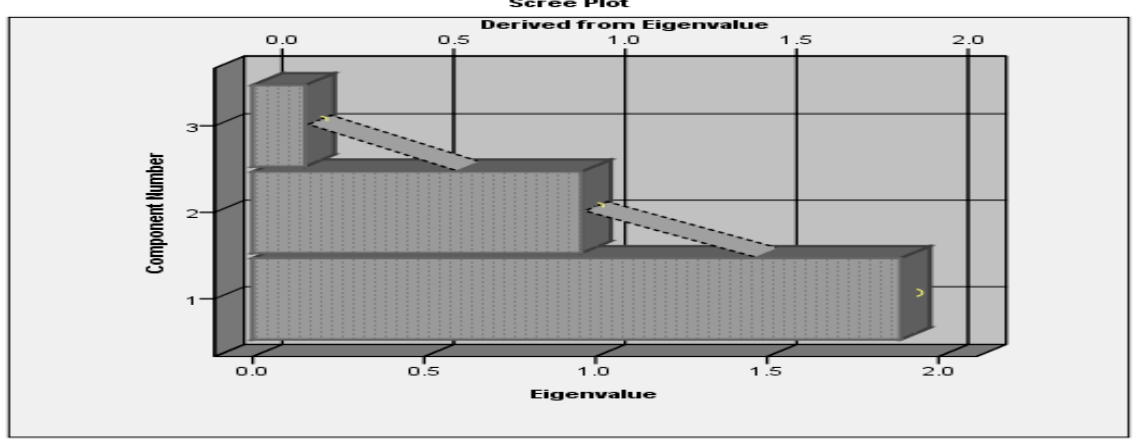
Figure 5. Scree plot of the second sub-factor (F1.2) of sustainable profit.